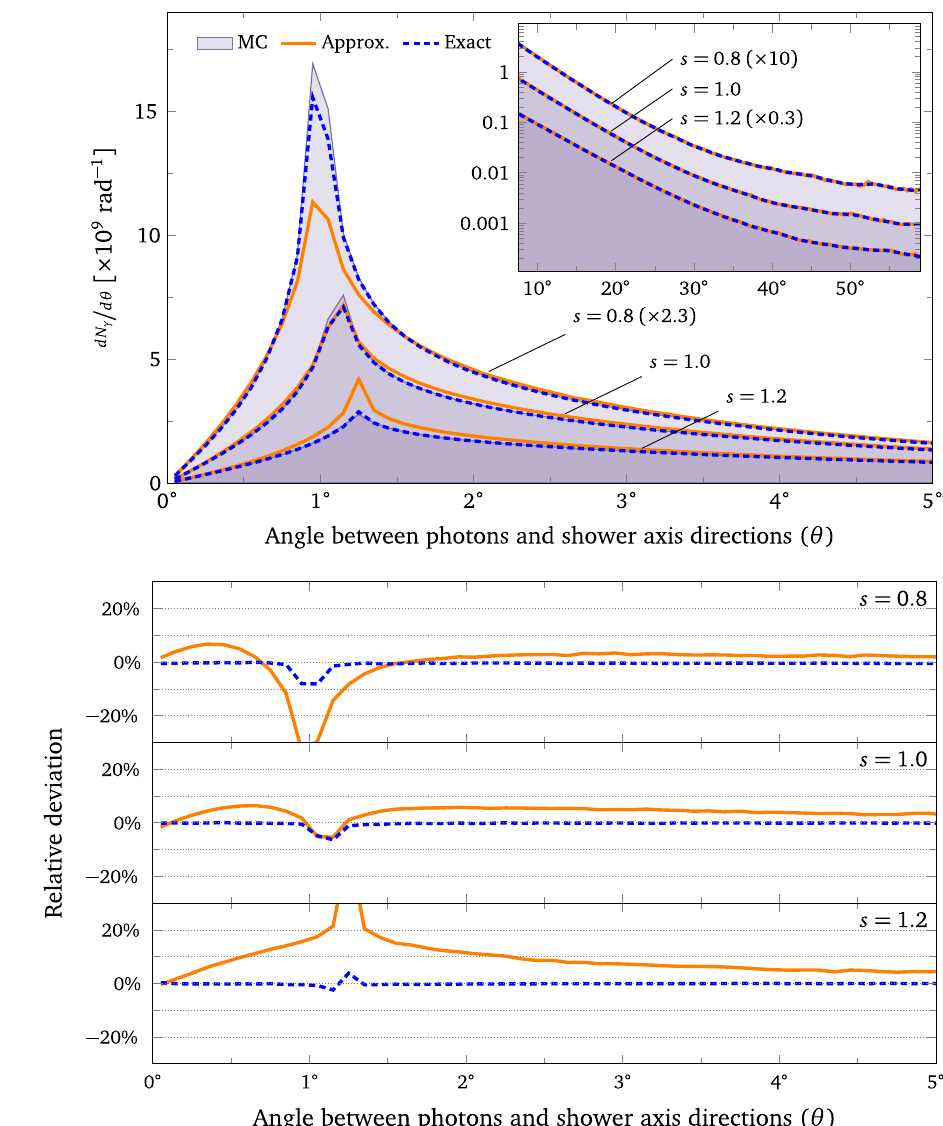
Fig. 7 Comparison of the exact (blue dashed) and the approximated (orange solid) models of Sects. 2 and 3 to a simulated angular distribution of Cherenkov photons at three shower ages (see annotations inside the box). The inset plot shows the region θ > 5 ◦ . To avoid superposition of the curves and therefore make the figure more clear, some curves were scaled by factors indicated together with the shower age